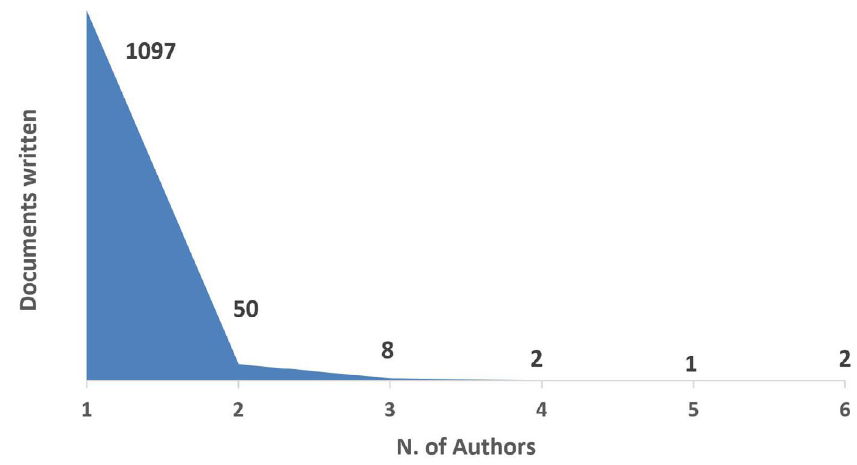
Fig. 1. The authors frequencey by Lotka’s law.